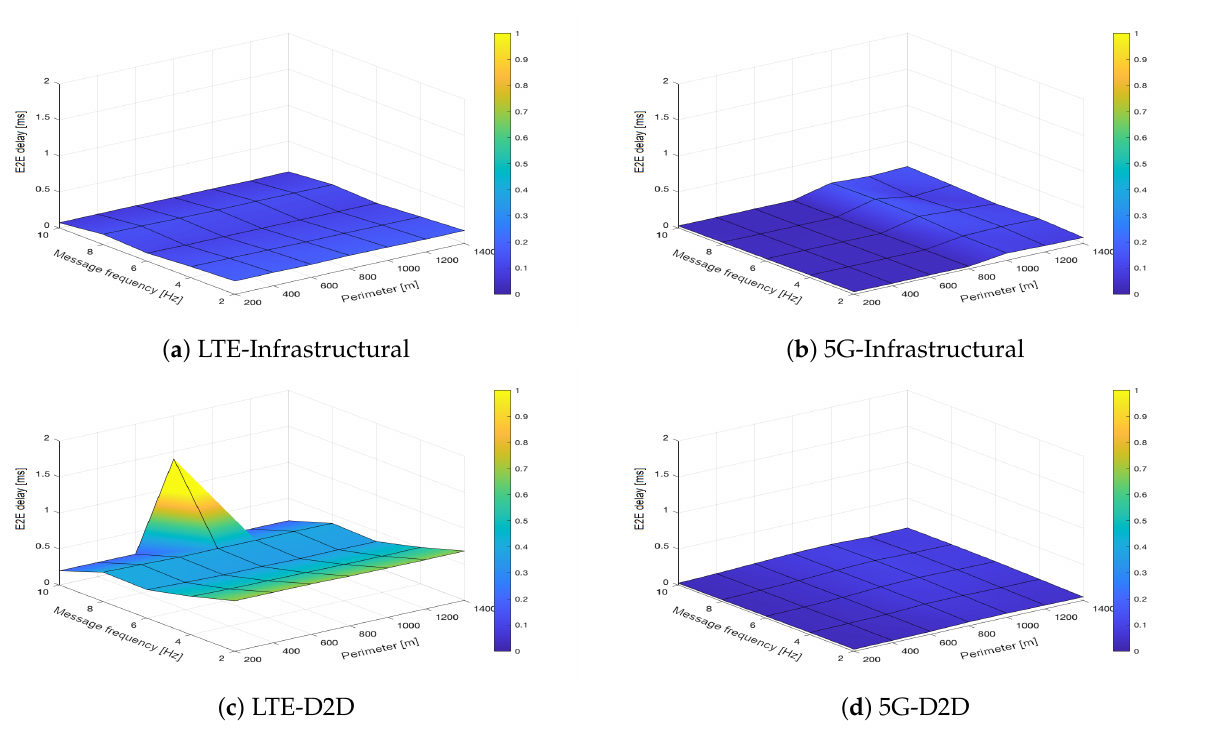
Figure 13. E2E latency simulated for all the investigated modes of the 4G-based and 5G-based C-V2X technologies and traffic intensity of 1500 vehicles per